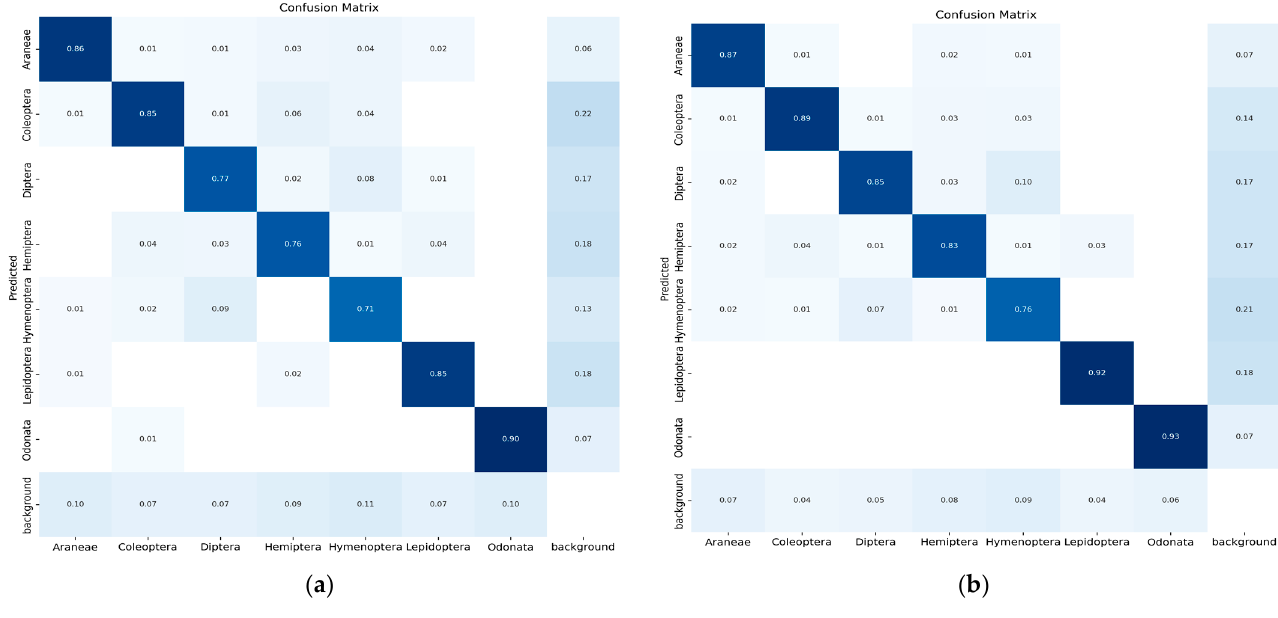
Figure 8. Detection results of YOLOv5x on di ff erent insect species.